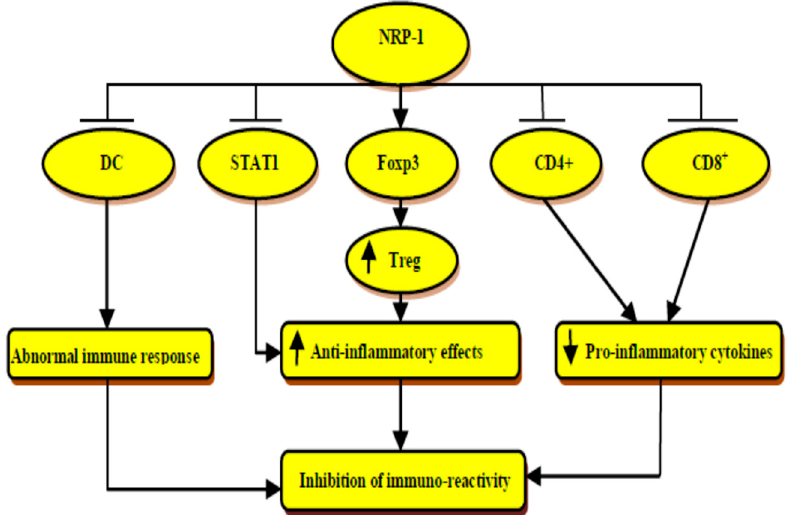
Figure 5. The immunological role of neuropilin-1 (NRP-1): Through transcription factor (Foxp3) and inhibition of signal transducer activator transporter 1(STAT1) NRP-1 activates regulatory T cell (Treg) and the release of anti-inflammatory cytokines, respectively. NRP-1 inhibits the release of pro-inflammatory cytokines through the inhibition of CD4+ and CD8+. NRP-1 through the SUPPRESSION of dendritic cells (DCs) attenuates abnormal immune response. These changes that are mediated by NRP-1 inhibit the development of immunological over-activity.